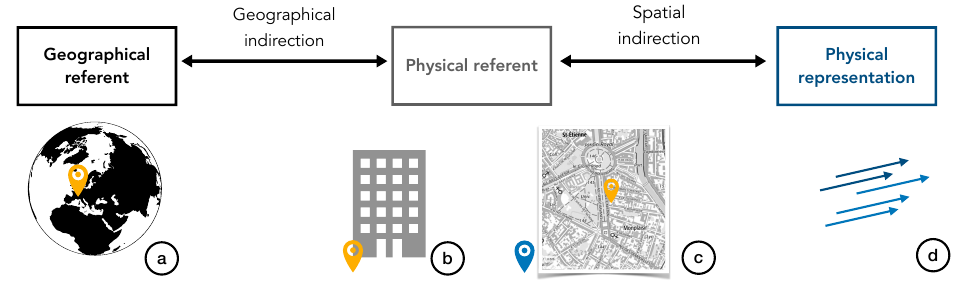
Figure 1. Schema representing the geographical referent (a) corresponding to a geographical position, the physical referent (b-c), and the physical representation (d). The geographical indirection represents the distance between the geographical referent and the physical referent . They can be the same (a) or a scaled referent such as a map can be used (c). The spatial indirection represents the distance between the physical referent and the physical representation